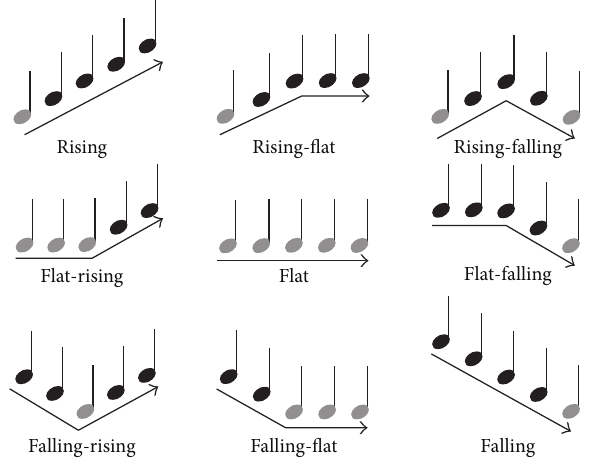
Figure 1: The 9 melodic contours used in the Melodic Contour TrainingProgram.Thelowestnotesaremarkedingrey.FromGalvin III et al.